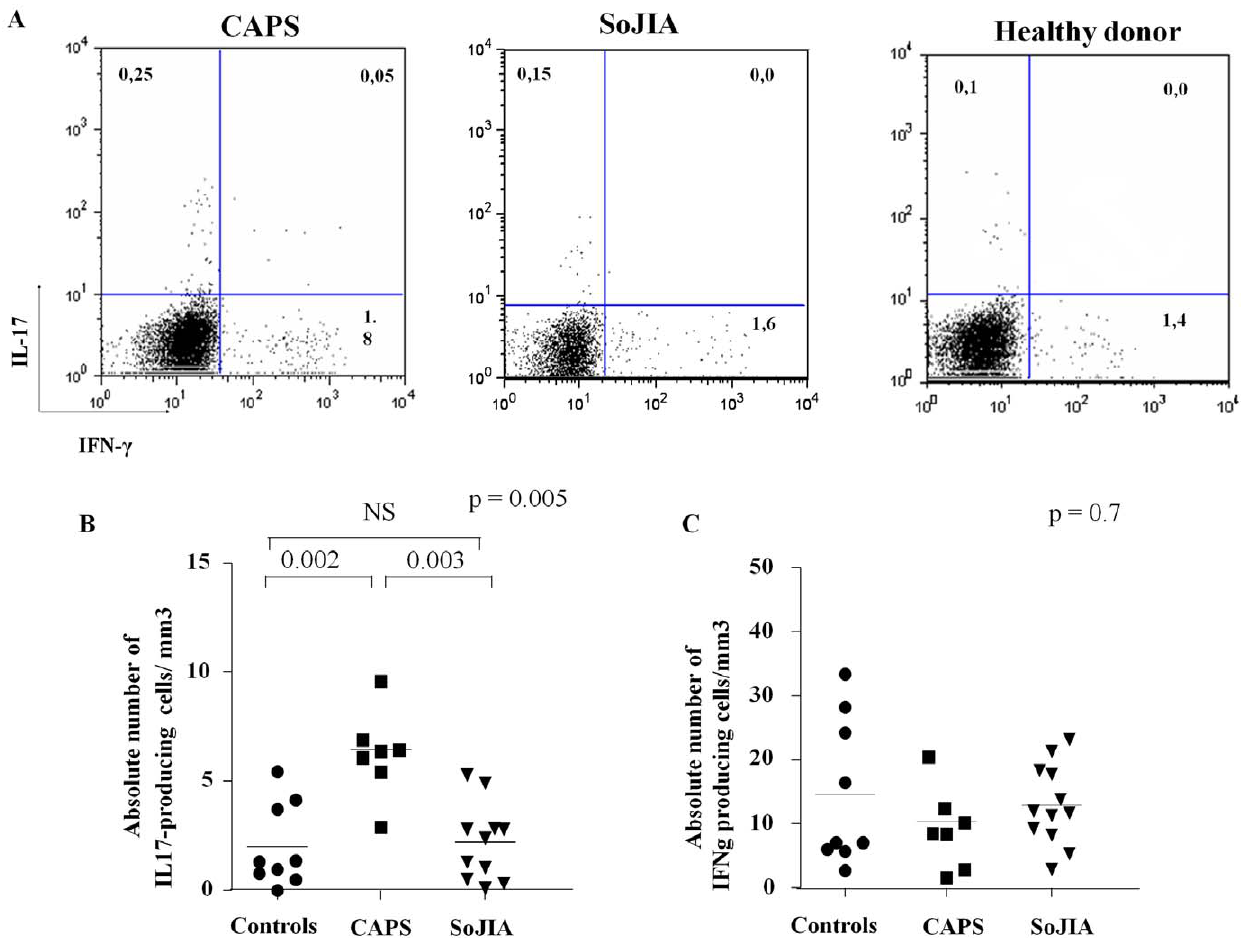
Figure 2. CAPS patients show an higher absolute number of IL-17 producing cells after invitro expansion. A) Dot plot electronically gated on alive CD4 + T cells of one representative CINCA patient, one systemic onset juvenile idiopathic arthritis (SoJIA) patient and one healthy control B–C) Absolute number of IL-17 (panel B) and IFN- c (panel C) producing cells in 7 NLPR3-mutated CAPS and 12 SoJIA active patients and in 9 age-matched healthy controls. Heterogeneity test among groups was evaluated using the non parametric Kruskal-Wallis test (upper right of each graph). Post-hoc analysis with non-parametric U Mann-Whitney test revealed the difference among the three subgroups.